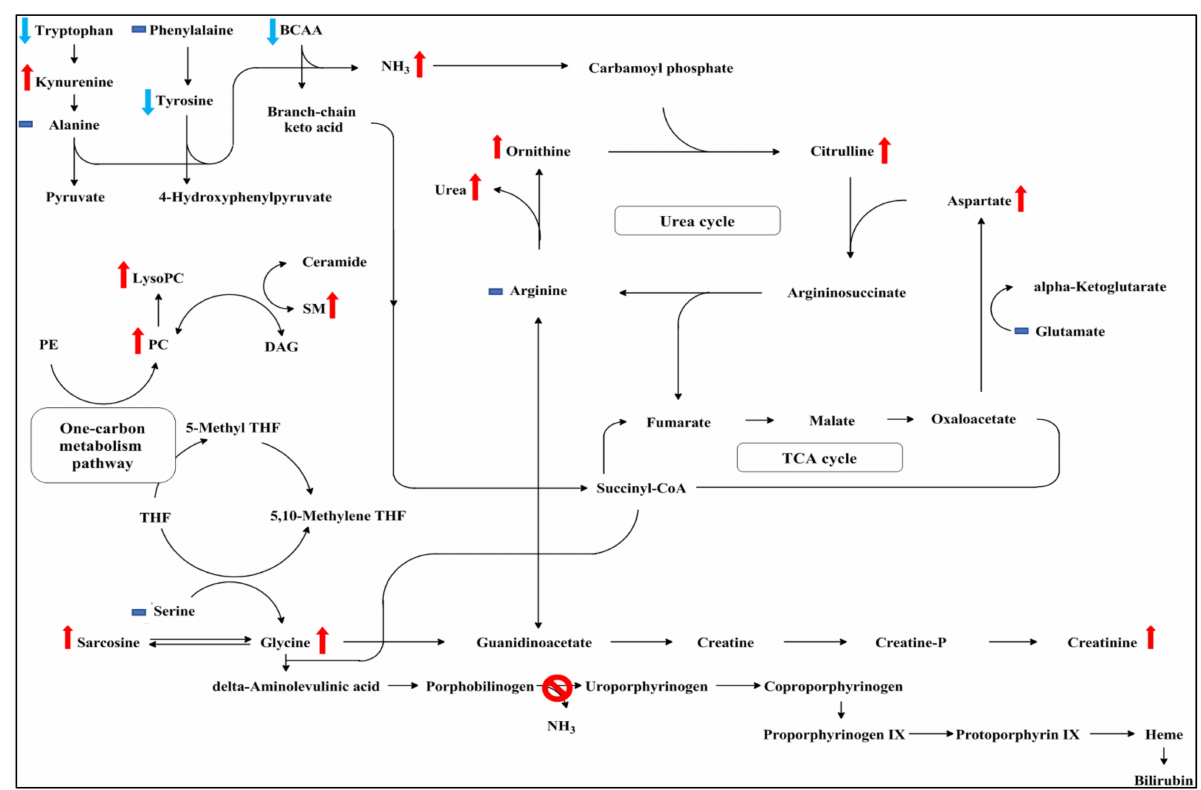
Figure 4. Putative metabolic pathway based on serum metabolic profiling results. Baseline serum metabolic profiles differ between normal participants and AIP patients, including amino acids, sphingomyelins, glycerophospholipids, and markers for urea cycle, TCA cycle, glycine, and creatinine synthesis. In AIP patients, the levels of branched-chain amino acids (BCAA: Valine, Leucine, Isoleucine), and aromatic amino acids (AAA: Tryptophan, Tyrosine), were significantly lower (indicated by light blue arrows); levels of the sphingomyelin (SM) (C16:0, C24:0, C24:1), phosphatidylcholine diacyl (C32:1, C36:1, C36:3), and LysoPC in the one-carbon metabolism pathway were higher (indicated by red arrows). Alterations in glycine synthesis, creatinine metabolism, and urea cycle were evident from the elevated levels of serine, sarcosine, glycine, urea, citrulline, ornithine, and aspartate in AIP patients (indicated by red arrows). Blue horizontal bar indicates no difference. Unlabeled metabolites were not quantified in this